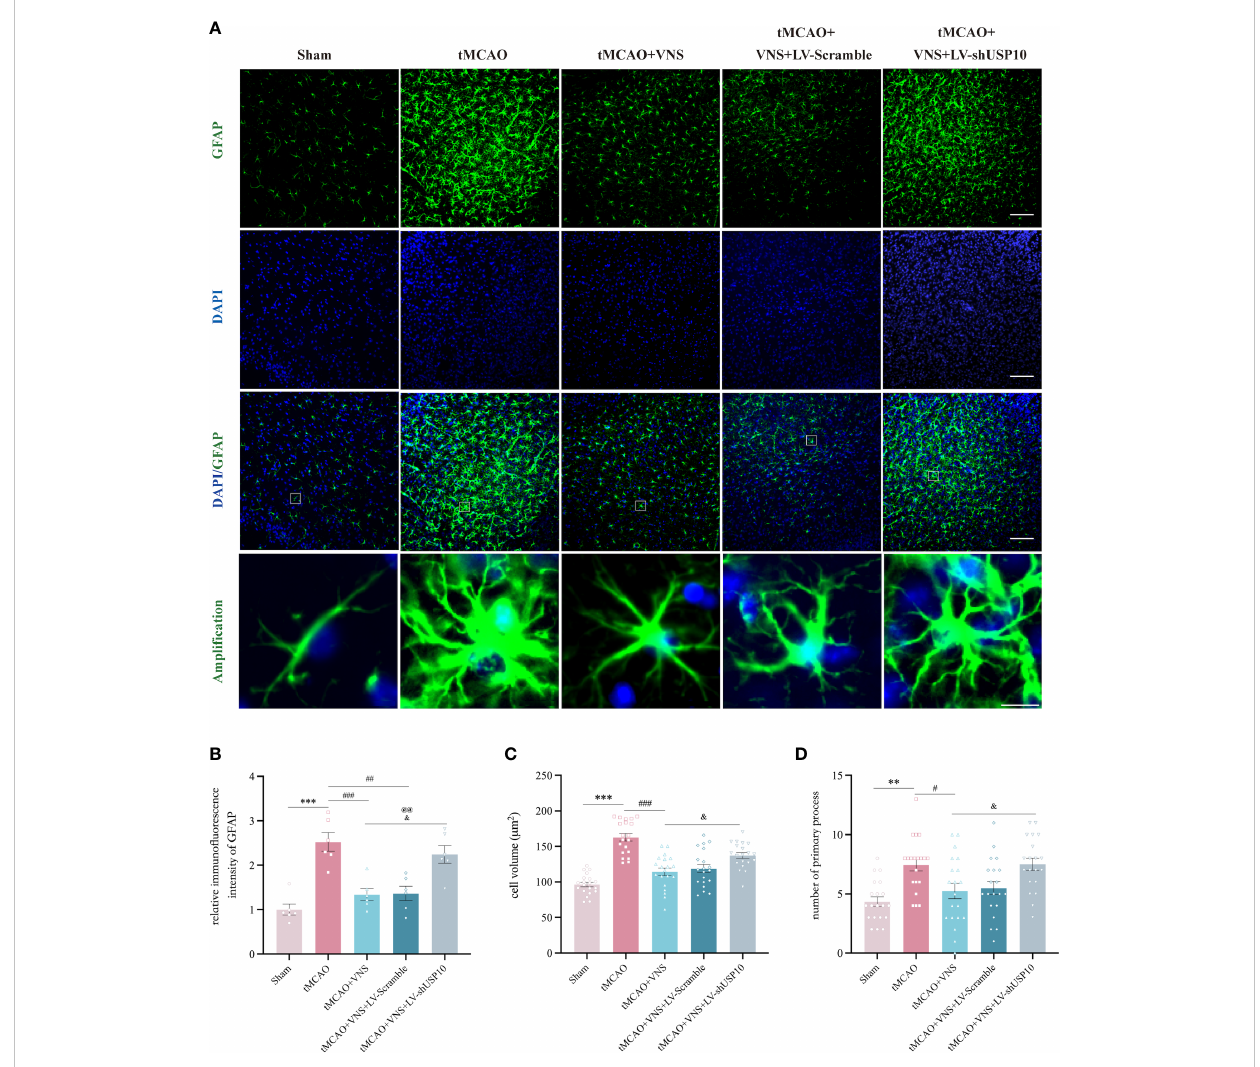
FIGURE 8 USP10 was involved in the inhibition of astrocyte activation by VNS. (A) Immuno fl uorescence staining of GFAP-positive astrocytes. n=6; (B) Quanti fi cation of the mean immuno fl uorescence intensity of GFAP. n=20; (C) Quanti fi cation of the cell volume. (D) Quanti fi cation of primary process number. n=20, Scale bar (top three rows) =100 m m; Scale bar (the last row) =10 m m. Data are mean ± SEM. ***P<0.001 and **P<0.01 vs. Sham group, ###P<0.001, ##P<0.01, and #P<0.05 vs. tMCAO group. @@P<0.01 vs. tMCAO+VNS group. &P<0.05 vs. tMCAO+VNS+LV-Scramble